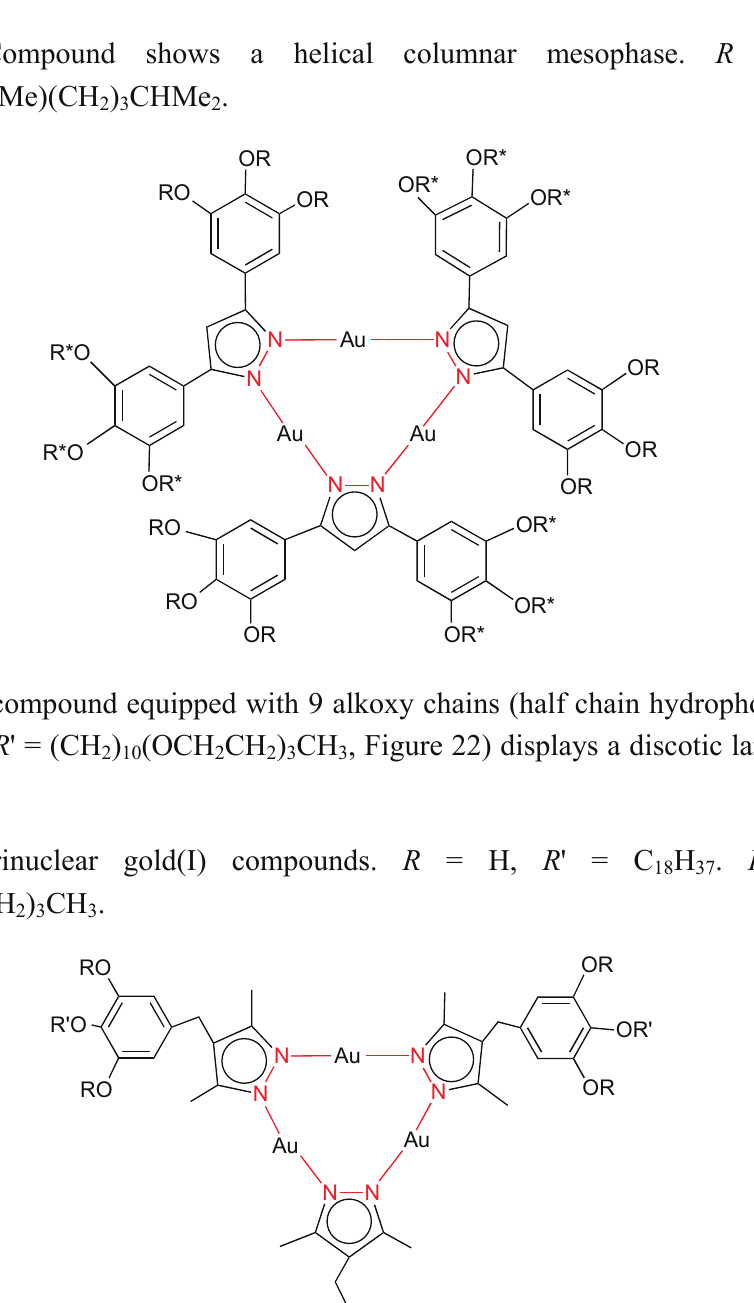
Figure 21. Compound shows a helical columnar mesophase. R = C R * = (CH